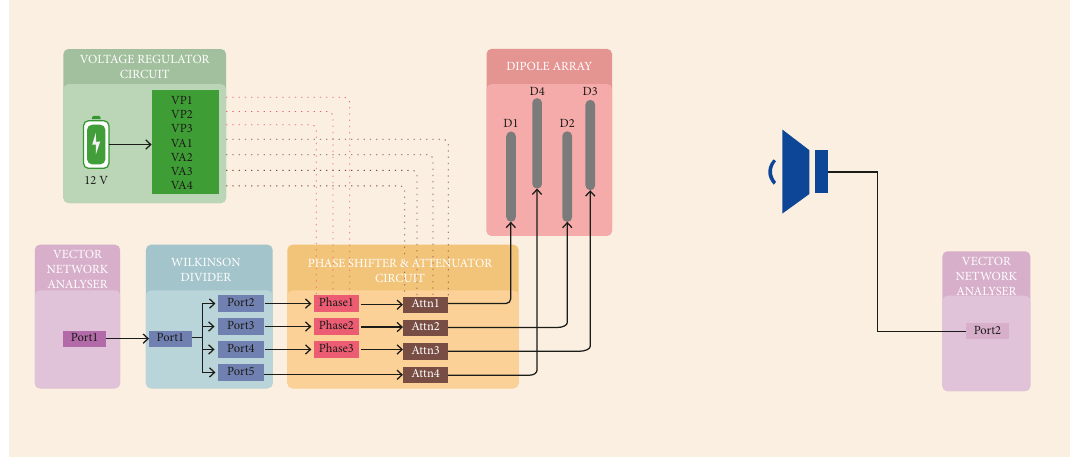
Figure 7: A block diagram of the dipole antenna array and its RF beamformer circuit as the transmitter and horn antenna as the receiver.